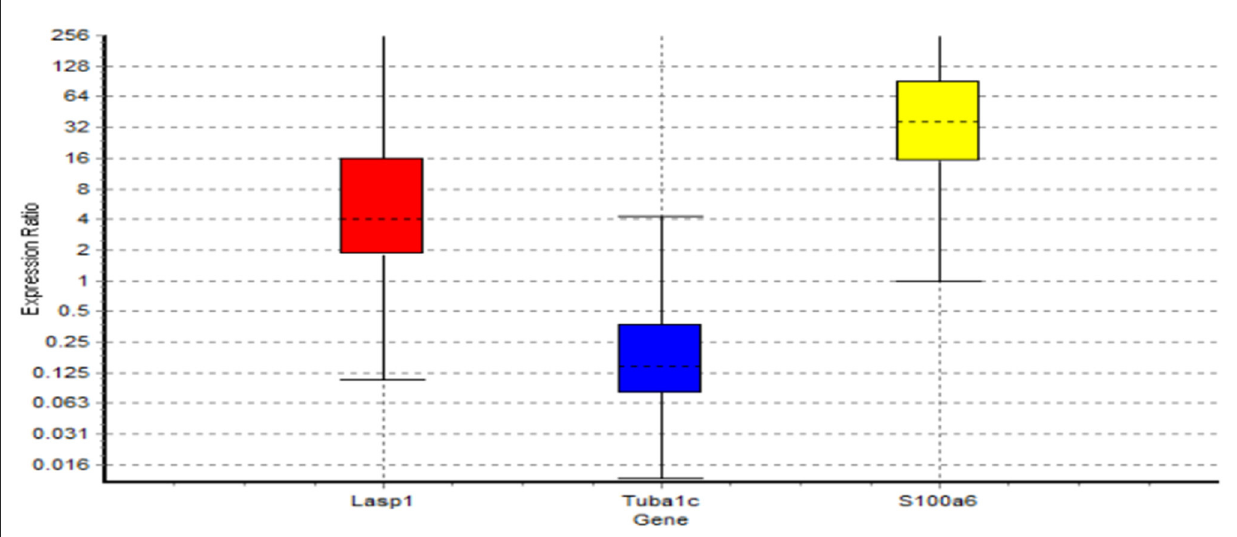
FIGURE5 Boxes represent the interquartile range, or the middle 50% of observations. The dotted line represents the median gene expression. Whiskers represent the minimum and maximum observations.